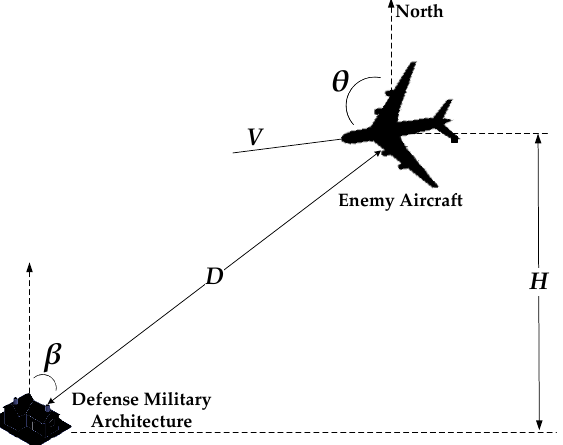
Figure 4. Relative geometric position of air combat. H is the flight height, D is the distance, V is the flight speed, θ is the heading angle, and β is the azimuth angle. Table 1. Numerical air target intelligence